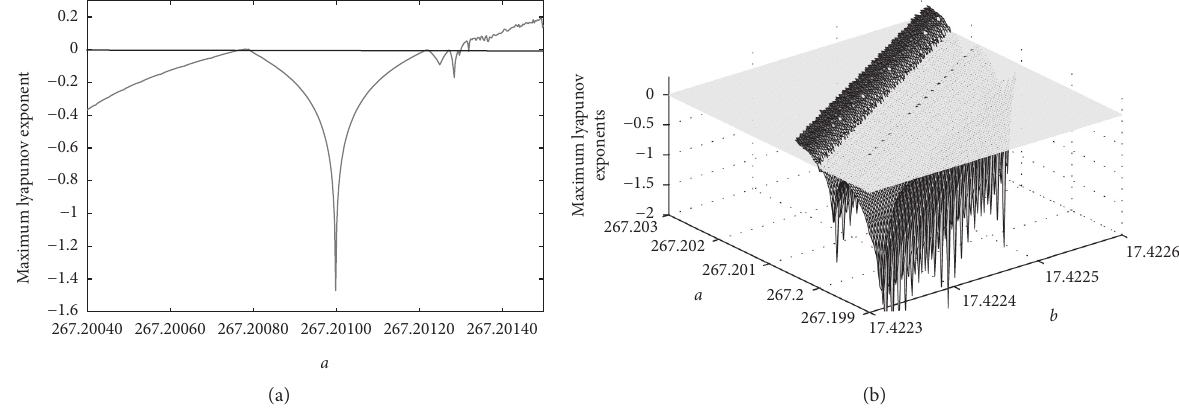
Figure 8: Maximum Lyapunov exponents of map (2) near (0.627048, 0.671077) as a and b varying: (a) in ( a − MLE ) plane with b � 17 . 42246 and (b) in ( b − a − MLE )